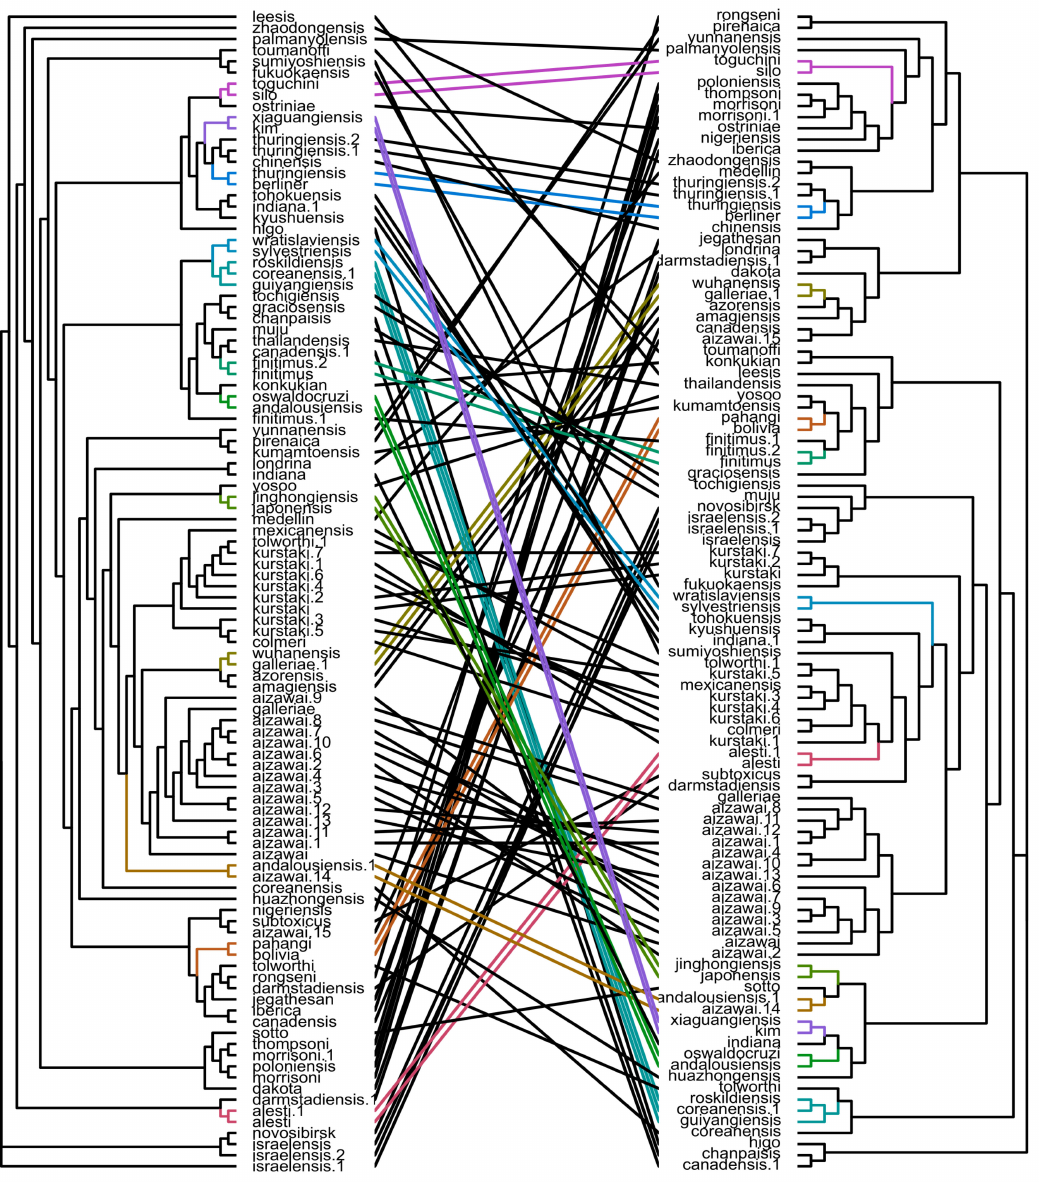
Figure 4. A tanglegram visualizing the differences in the topology of the core SNPs-derived tree and flagellin-based tree. Colored lines connect the subtrees with identical topology in both trees. Trees with supporting values and the lengths of nodes specified are available as Figure